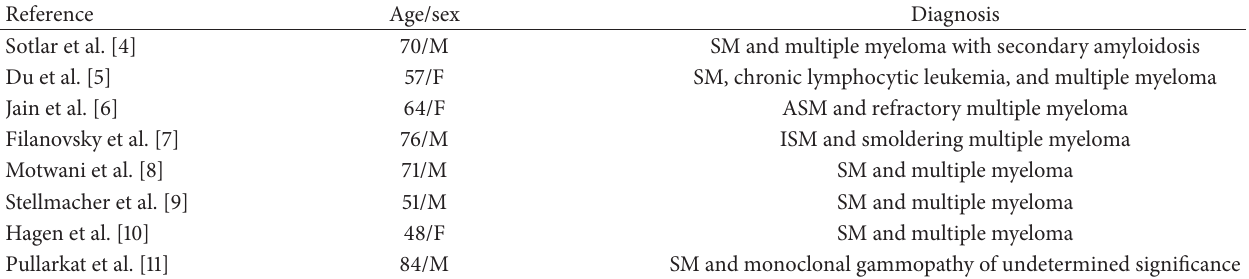
Table 1: Previously reported cases of SM with an associated plasma cell disorder.